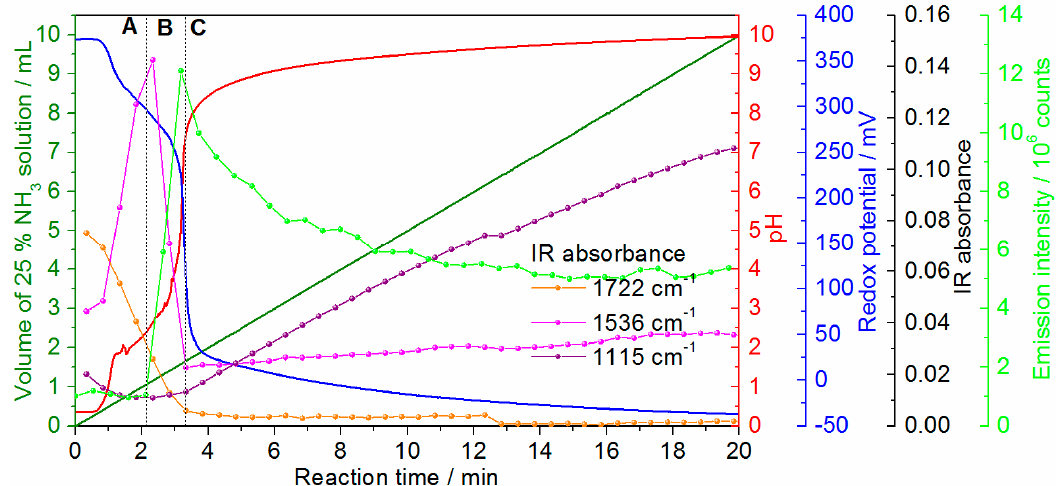
Figure 4. Dependence of the redox potential (blue curve), pH (red curve) emission intensity at 450 nm (light green curve, λ ex = 320 nm) as well as IR absorbance at 1722 cm − 1 (orange dots), 1536 cm − 1 (pink dots), and 1115 cm − 1 (purple dots) on the addition of the 25% NH 3 solution.